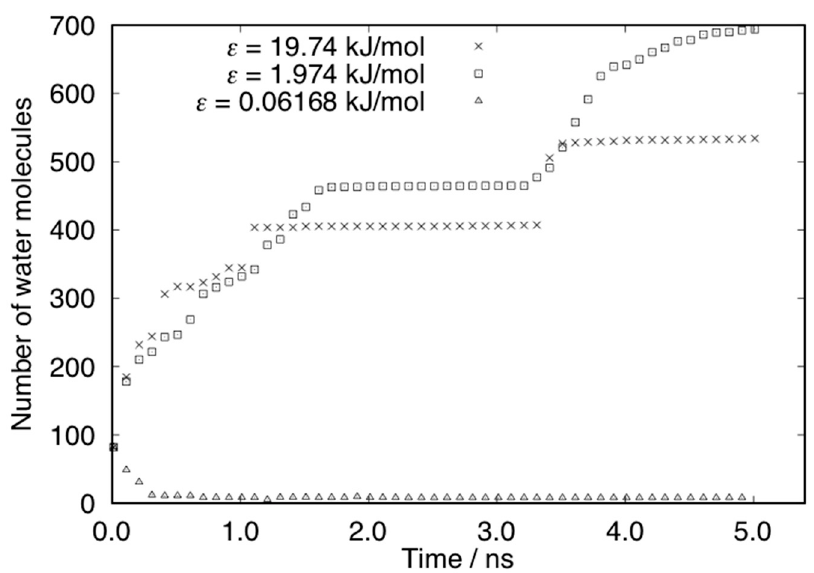
Figure 14. Number of water molecules in the nanostructure on surfaces.